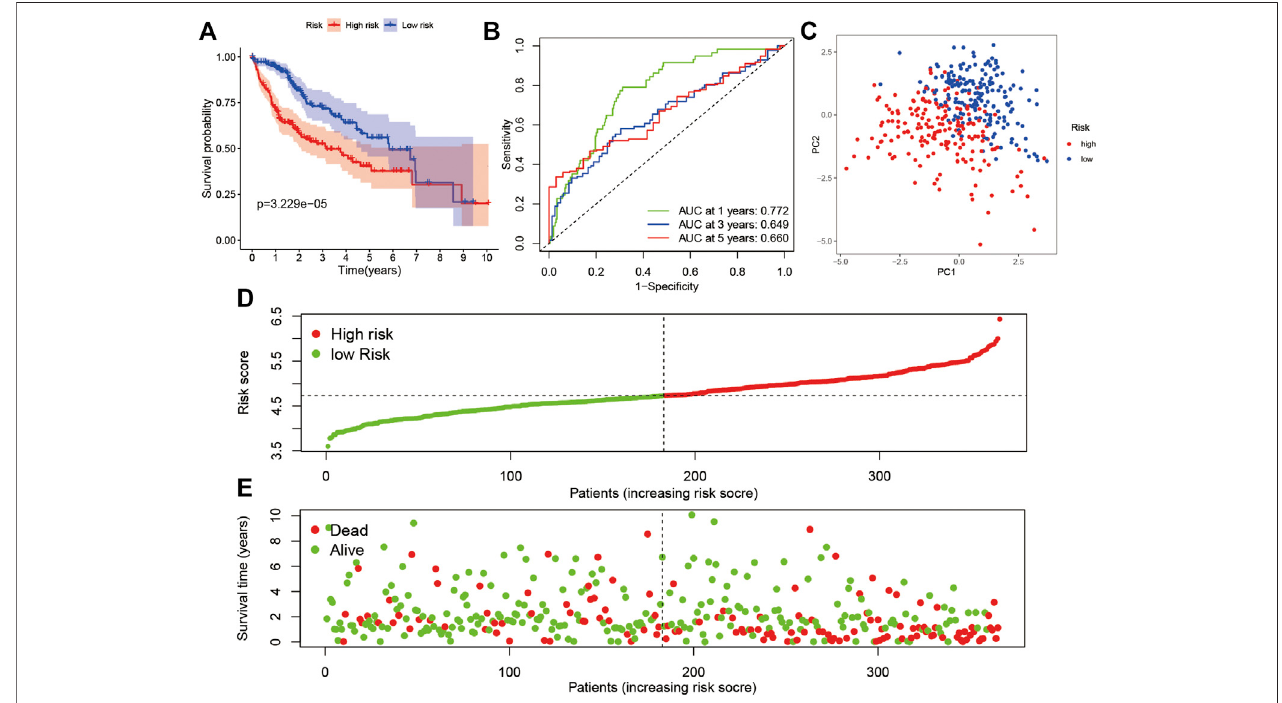
FIGURE3| Prognosticanalysisofthe9-genesignatureintheTCGAcohort. (A) Survivalanalysisinthetworisksubgroups. (B) AUCoftheriskmodel. (C) PCAplot. (D) The risk score of LIHC in TCGA cohort. (E) Distribution of survival status.